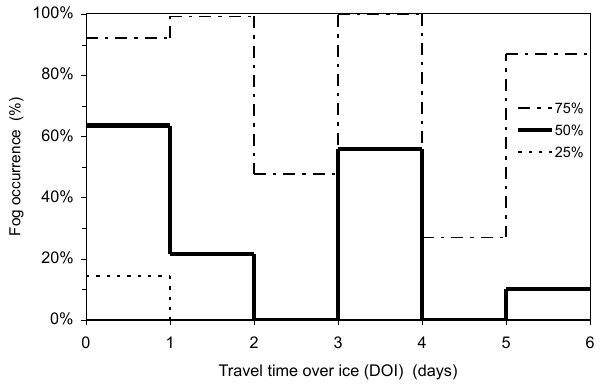
Fig. 3. 25%, 50%, and 75% Percentiles of fog occurrences as a function of travel time over ice (DOI, days). Data for all travel times of five days and longer have been collected in the column 5–6 days.